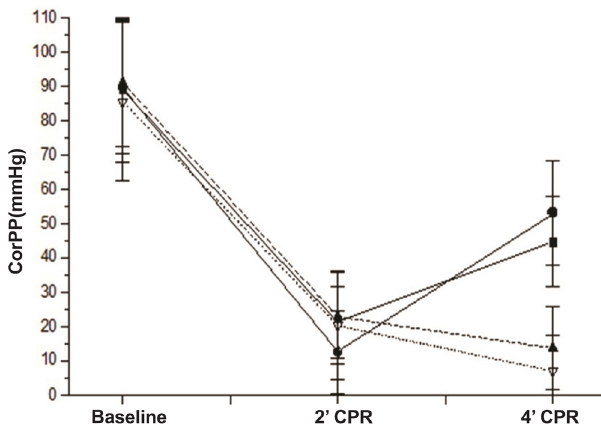
Fig. 3 - Comparative evolution of the variables assessed at baseline (0), 2 min of CPR (2) and 4 min of CPR in the groups studied. Average value and standard deviation of CorPP in each moment and